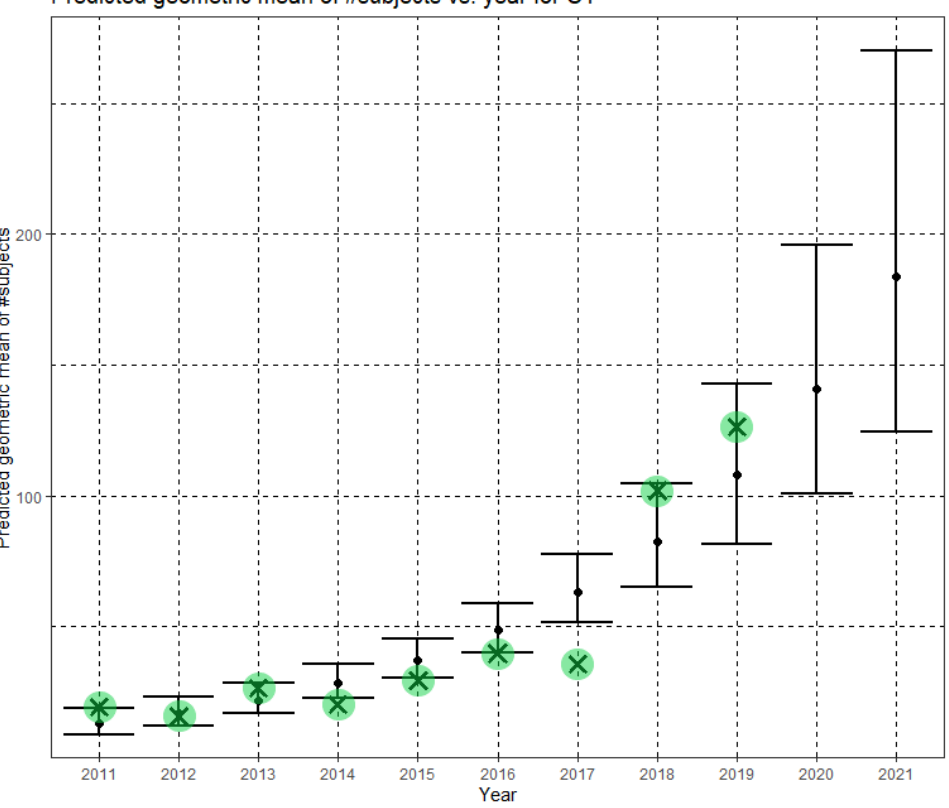
Figure 8. Phase II—Predicted geometric mean (black dots) and confidence intervals of dataset sizes in MICCAI articles involving CT for the years 2011–2021 based on the whole ensemble of 2011–2019 CT dataset sizes. The empirical geometric means (2011–2019) are shown (in green) for comparison (x marks). The empirical geometric means for 2020 and 2021 are not known at the time of writing .